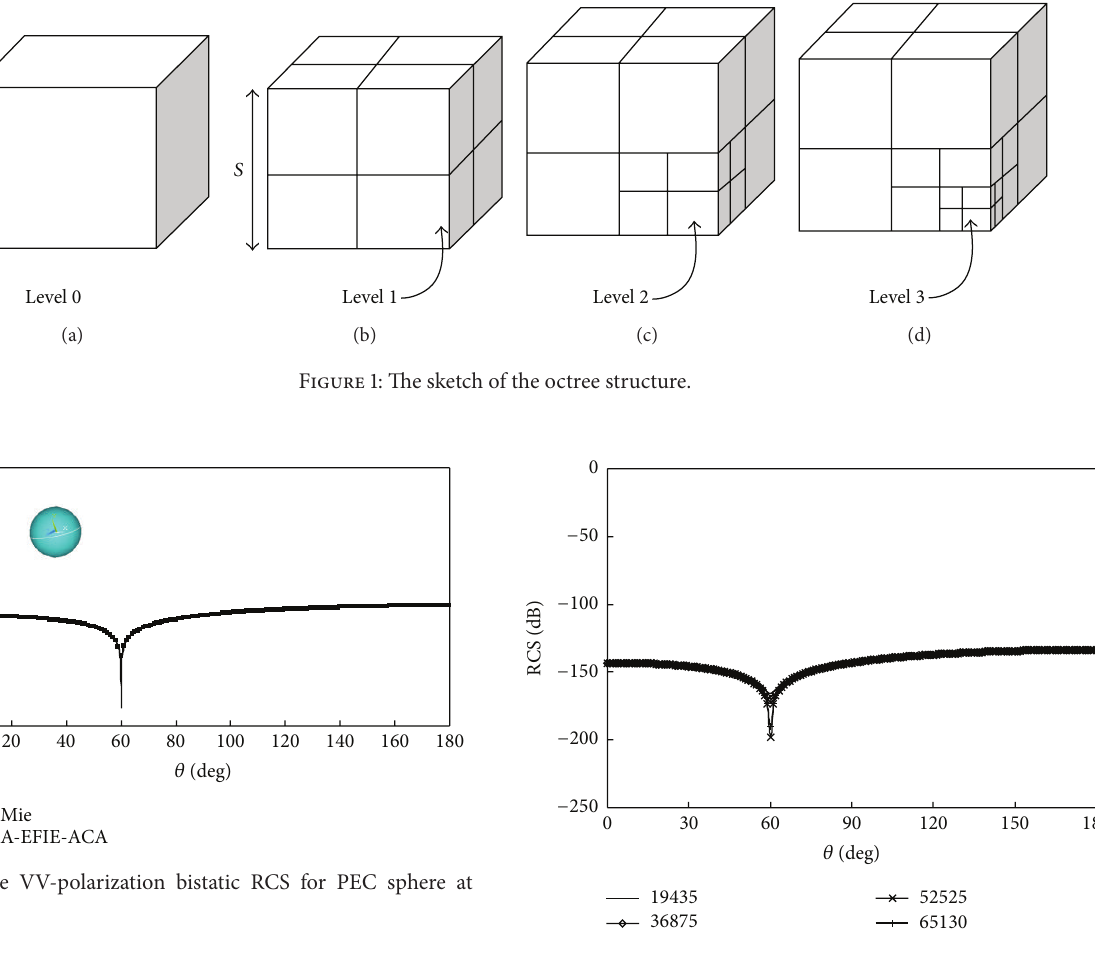
Figure 4: The VV-polarization bistatic RCS for PEC sphere with respect to the number of unknowns at